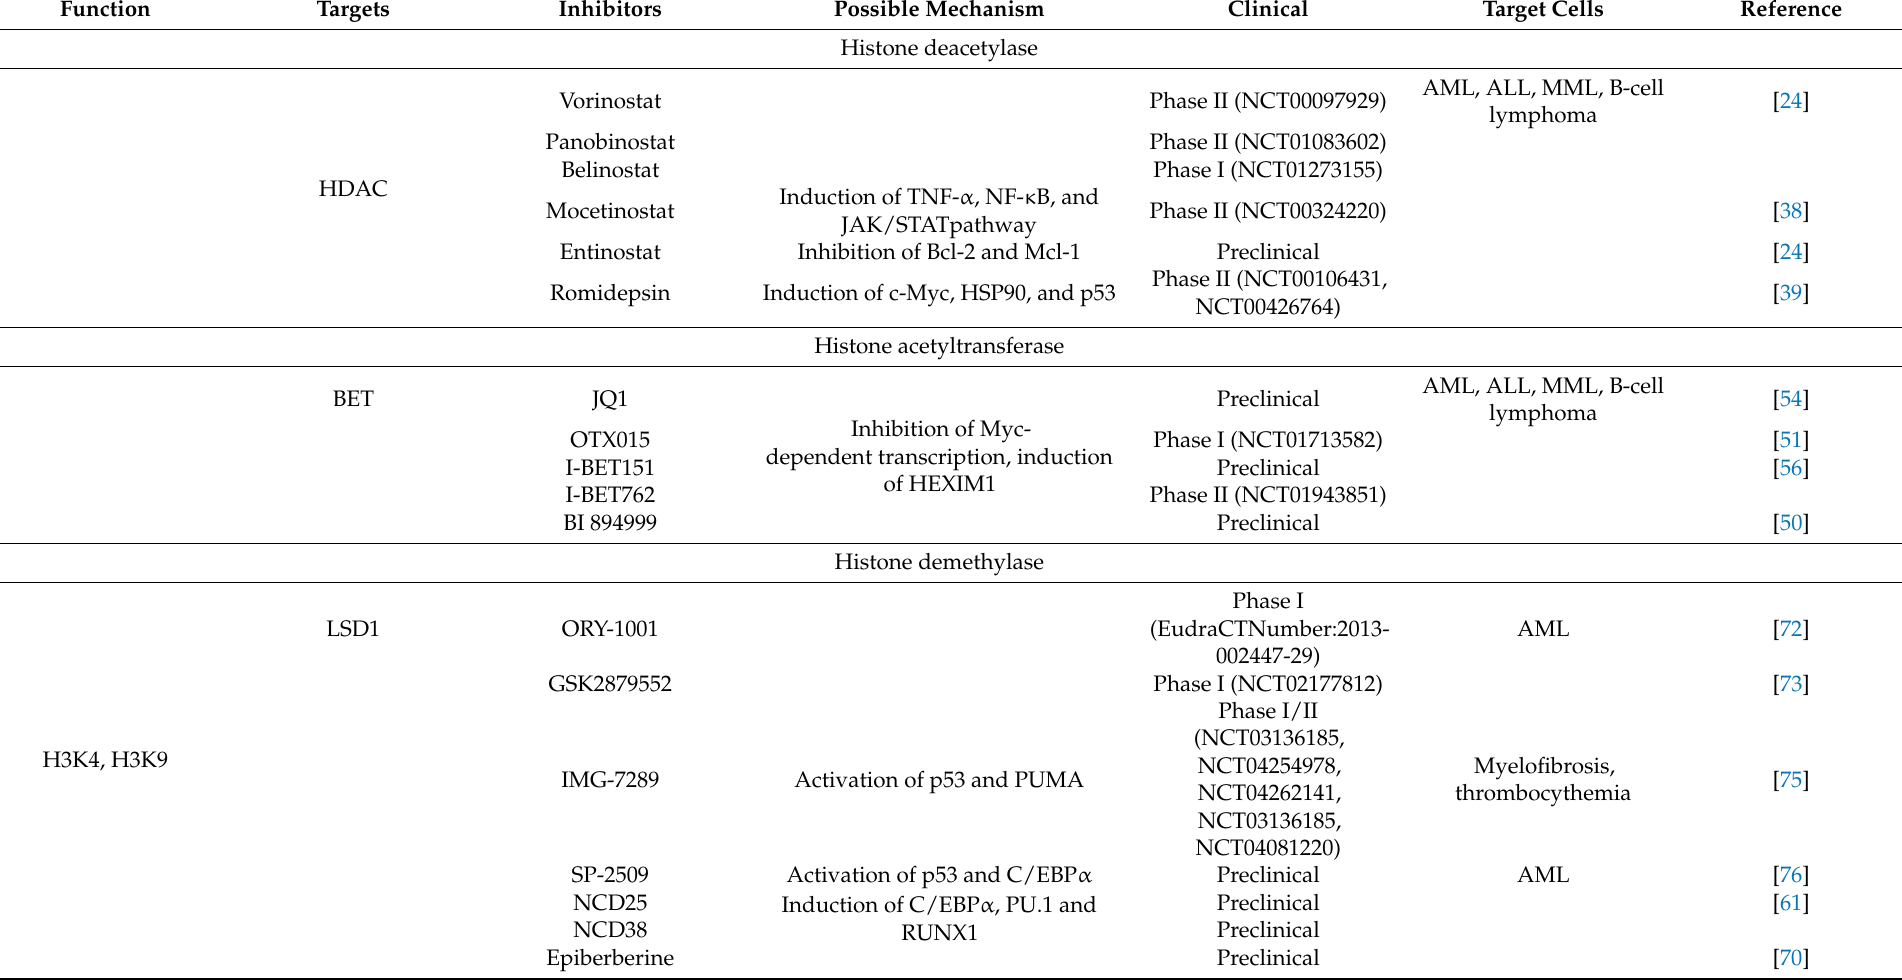
Table 2. List of inhibitors of key chromatin regulators, their predicted mechanism of antitumor effects, and the stage of